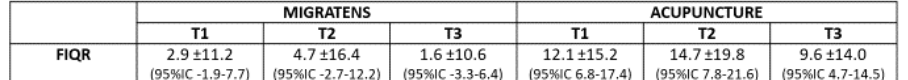
Figure 6. Reduction difference in VAS values in the two treatment groups during observation (values are expressed as mean difference ±SD).